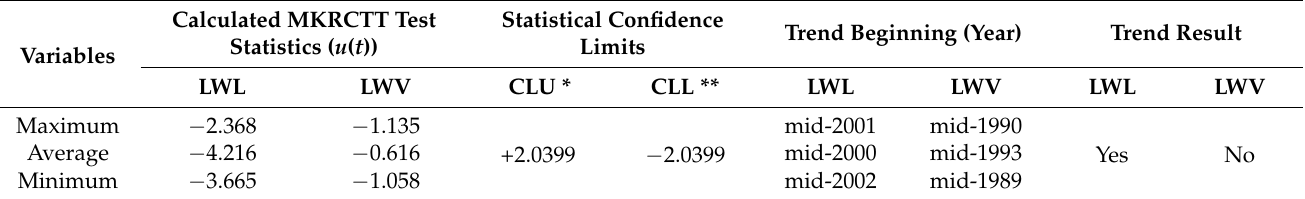
Table 7. MKRCTT for the lake water level (LWL) and lake water volume (LWV)